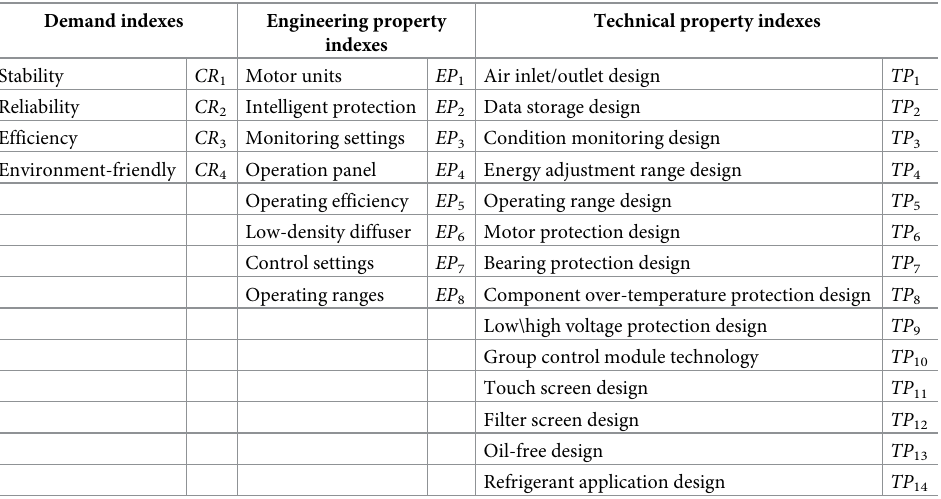
Table 5. Innovative design indicators of air-conditioning.